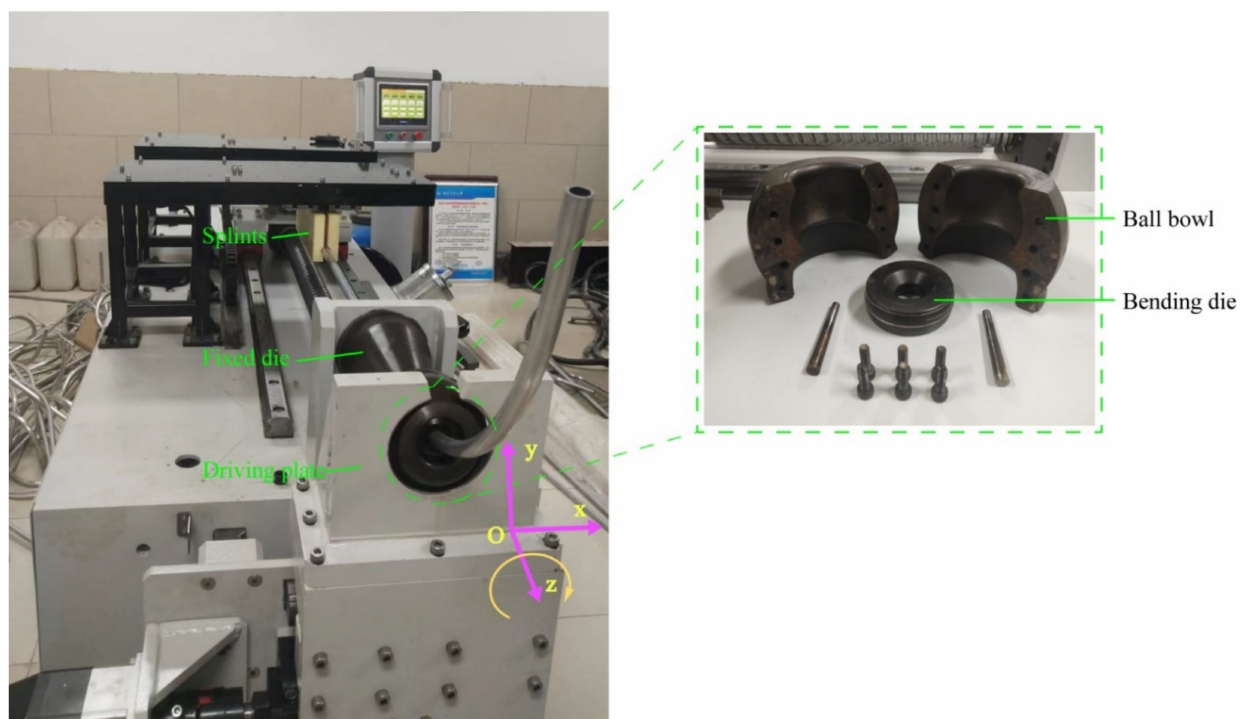
Figure 9. Four-axis free bending forming